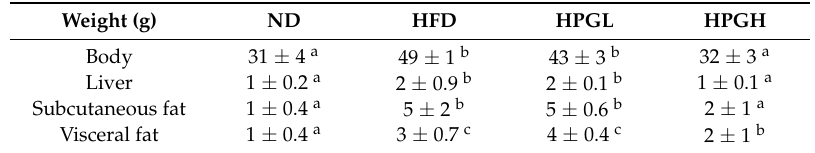
Table 1. Characteristics of mice fed a Normal Diet (ND), a High-Fat Diet (HFD), HFD with 1% Platycodon grandiflorum (PG) extract (HPGL), and HFD with 5% PG extract (HPGH).